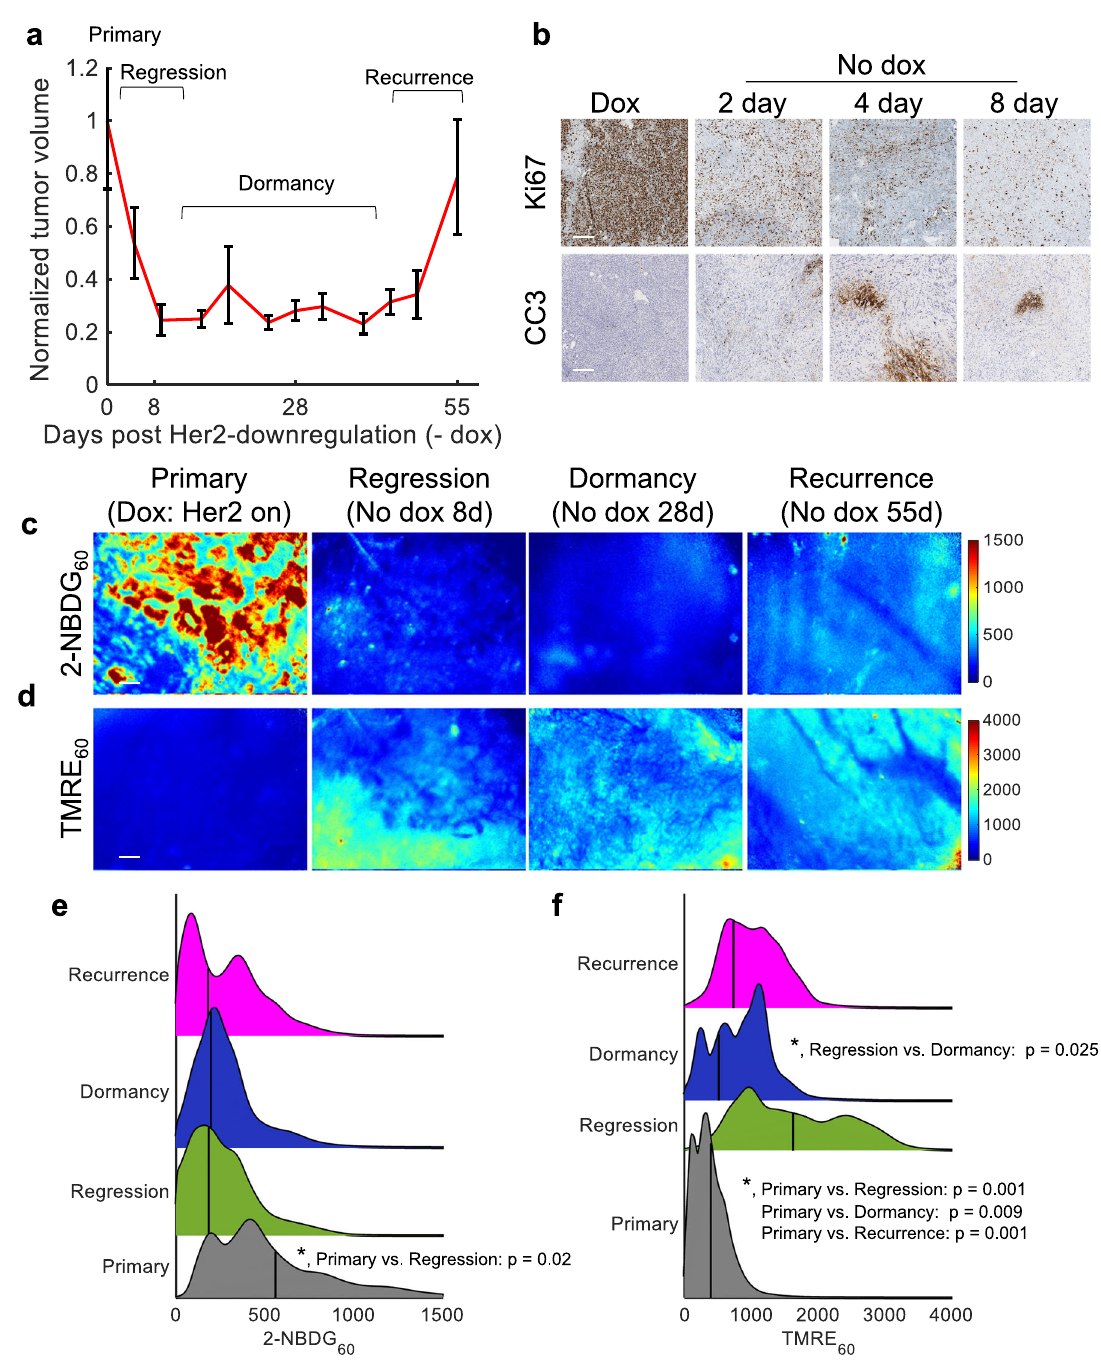
Fig. 1 Following oncogene ablation, regressing, dormant, and recurring tumors show decreased glucose uptake and increased mitochondrial membrane potential in vivo. 2-NBDG and TMRE uptake 60 min post-injection were imaged in mammary tumors overexpressing the oncogene Her2 ( + dox) and mammary tumors in which Her2 was downregulated via dox withdrawal. Recurrent tumors spontaneously re-grew ~55 days following Her2 downregulation. a Normalized average tumor volumes during the dormancy cycle where 0 days represents primary tumors (Her2 on). Error bar = standard error of the mean, ( n = 11). b Representative immunohistochemistry images stained for Ki67 (top, proliferation) CC3 (bottom, apoptosis) (brown). c , d Representative 2-NBDG 60 ( c ) and TMRE 60 ( d ) images in a primary mammary tumor on dox (Her2 on) ( n = 10), during regression (No dox 8 days) ( n = 10), during dormancy (No dox 28 days) ( n = 8), and upon recurrence (No dox 55 days) ( n = 7). Scale bar = 200 µm. e 2-NBDG 60 probability density function (PDF) ridgeline plots for primary, regressing, dormant, and recurrent time points across all pixels and all mice at each time point. f TMRE 60 probability density function (PDF) ridgeline plots for primary, regressing, dormant, and recurrent time points across all pixels and all mice at each time point. Vertical lines superimposed on PDF curves report the average fl uorescence. Statistical comparisons were performed using a Kolmogorov-Smirnov (KS)